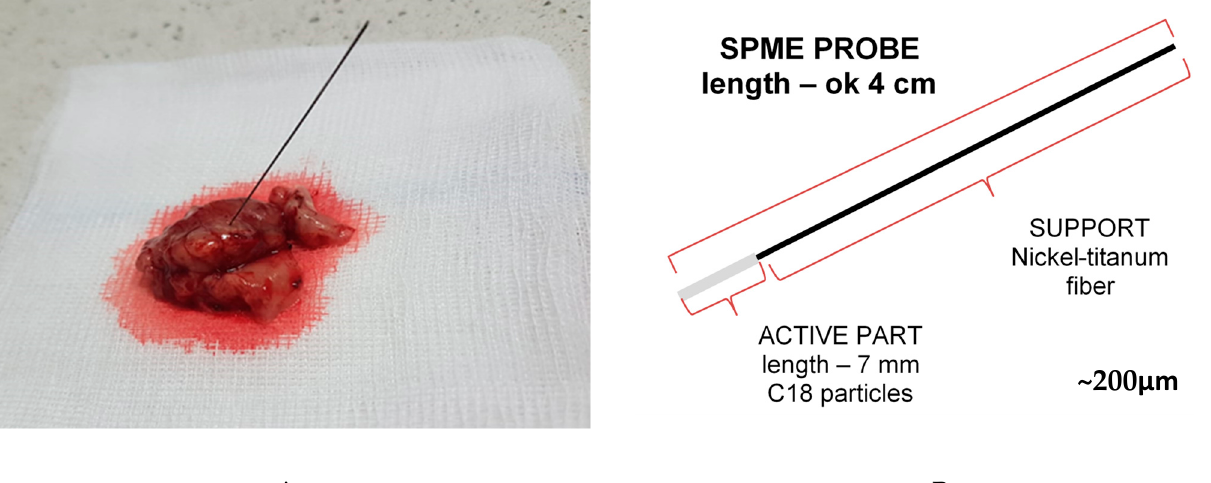
Figure 1. Chemical biopsy probes: ( A ) SPME probe during the sampling of a brain tumor; ( B ) the construction of the SPME probes.